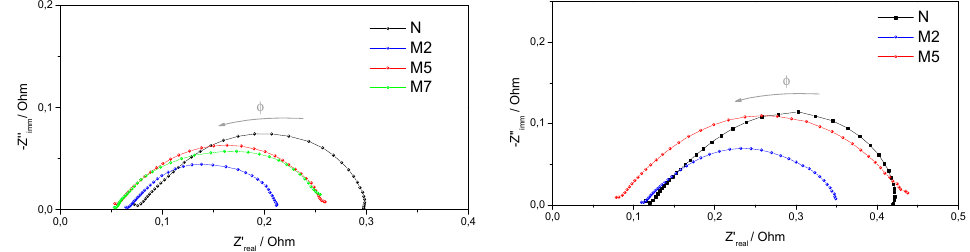
Figure 6. Impedance spectra recorded at 0.6 V, under 31% RH and at T = 80 °C ( on the left ) or at T= 110 °C ( on the right ). Frequency range, Ф : 10 KHz - 1Hz.